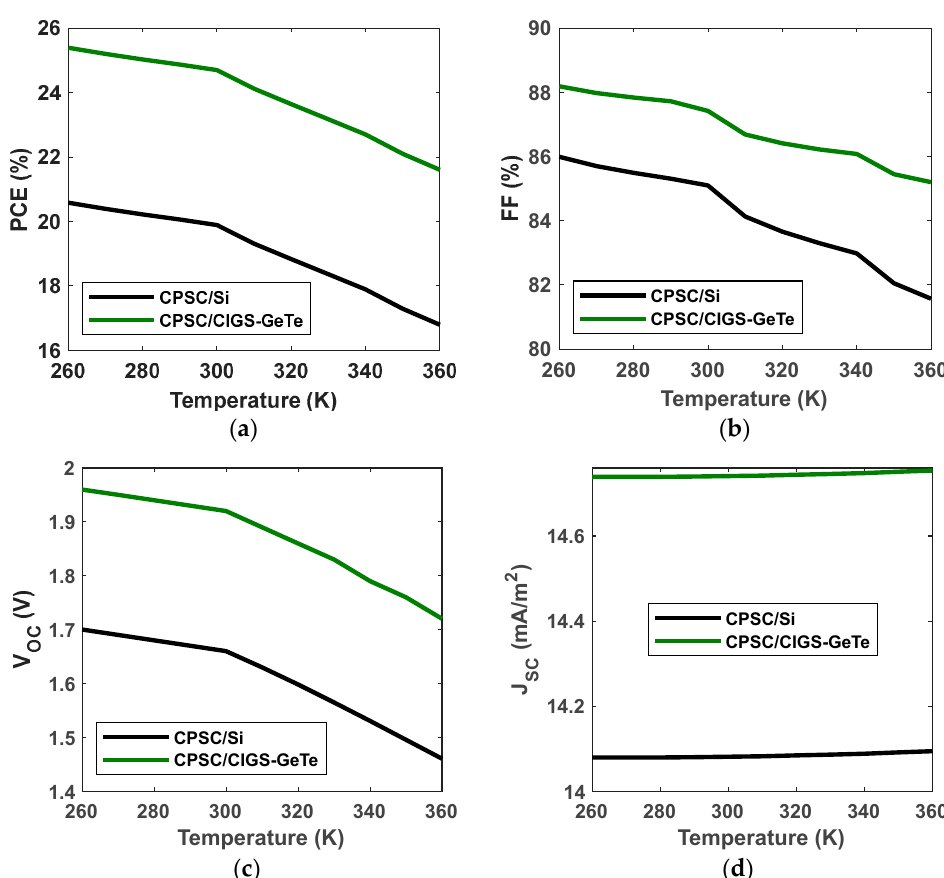
Figure 10. Performance parameters of CPSC-based tandem solar cells under the variation of temperature: ( a ) PCE, ( b ) FF, ( c ) V OC , and ( d ) J SC.